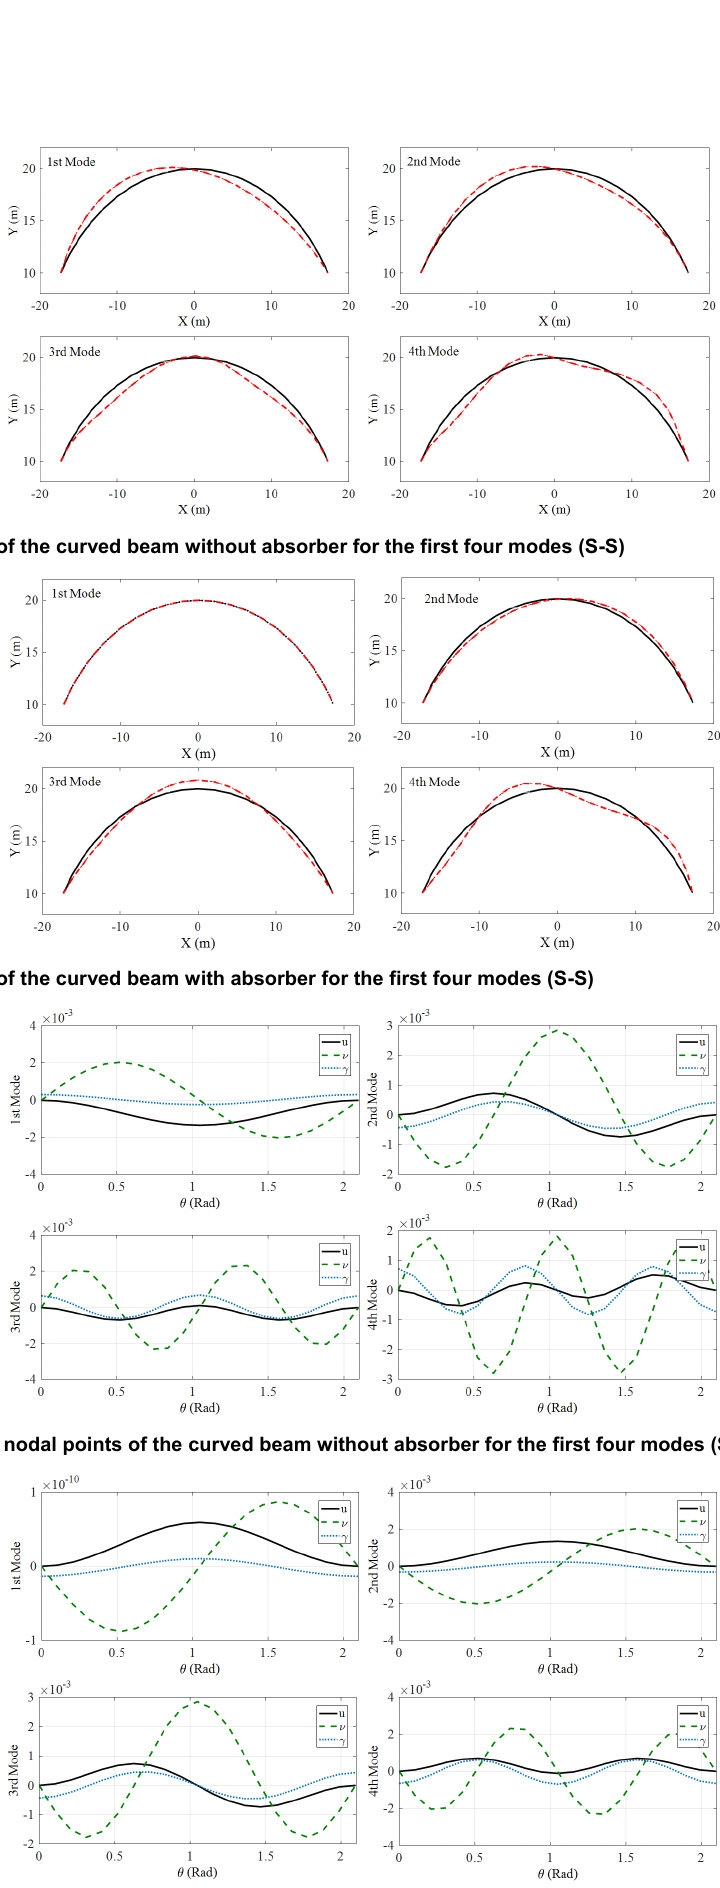
Figure 11. Displacement of nodal points of the curved beam with absorber for the first four modes